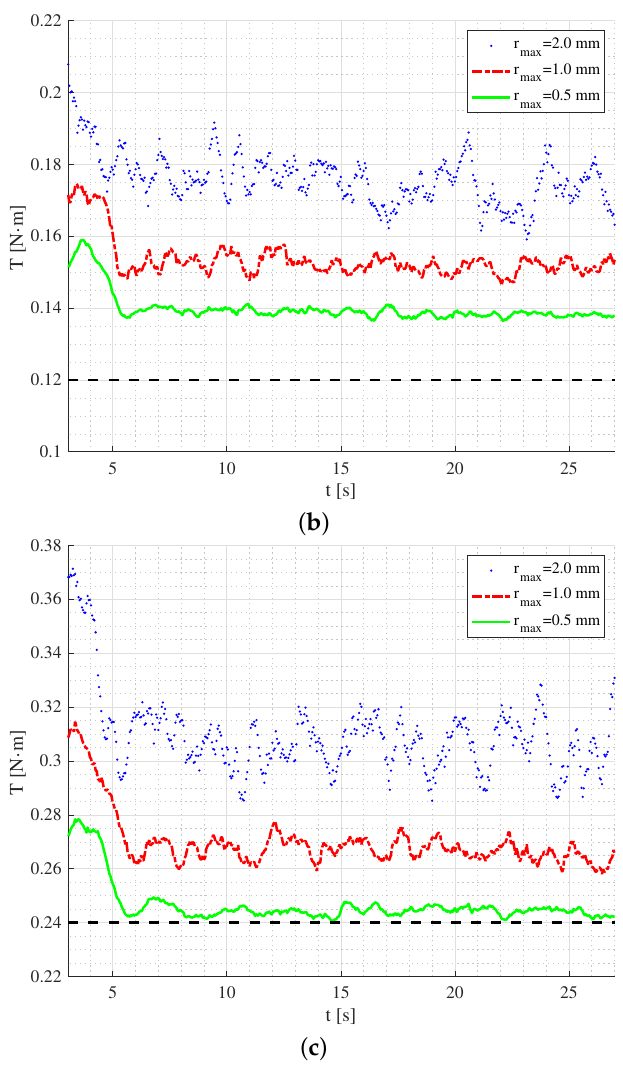
Figure 7. Torques on the mixer head measured during the DEM simulations for Case 1 ( a ), for Case 2 ( b ) and for Case 3 ( c ): the state-state value in the experiments represented by dashed